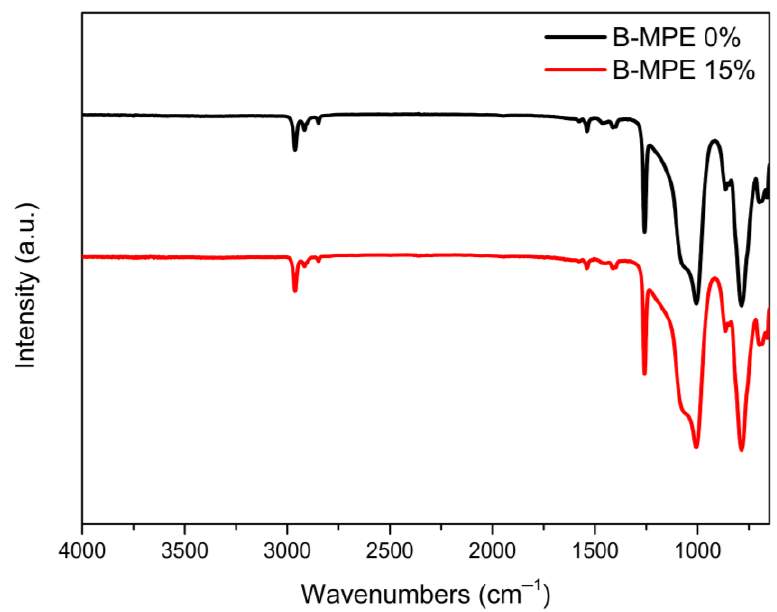
Figure 4. Fourier transform infrared (FT-IR) spectra of the Bioelastomer–MPE 0% (control, PMDS, black) and the Bioelastomer–MPE 15% (red).